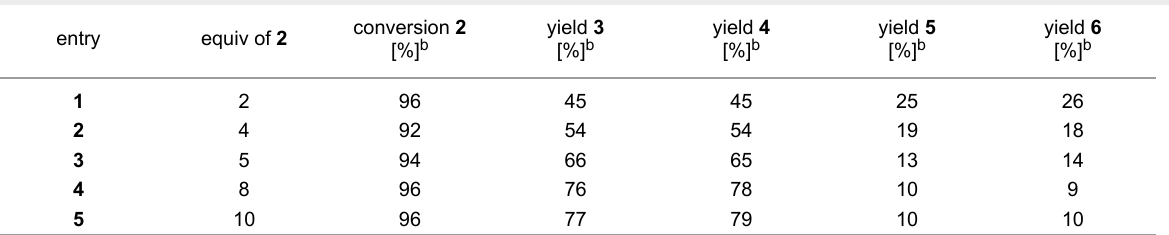
Table 3: Results of catalytic investigations of cross-metathesis of 1 with various amounts of 2 . a